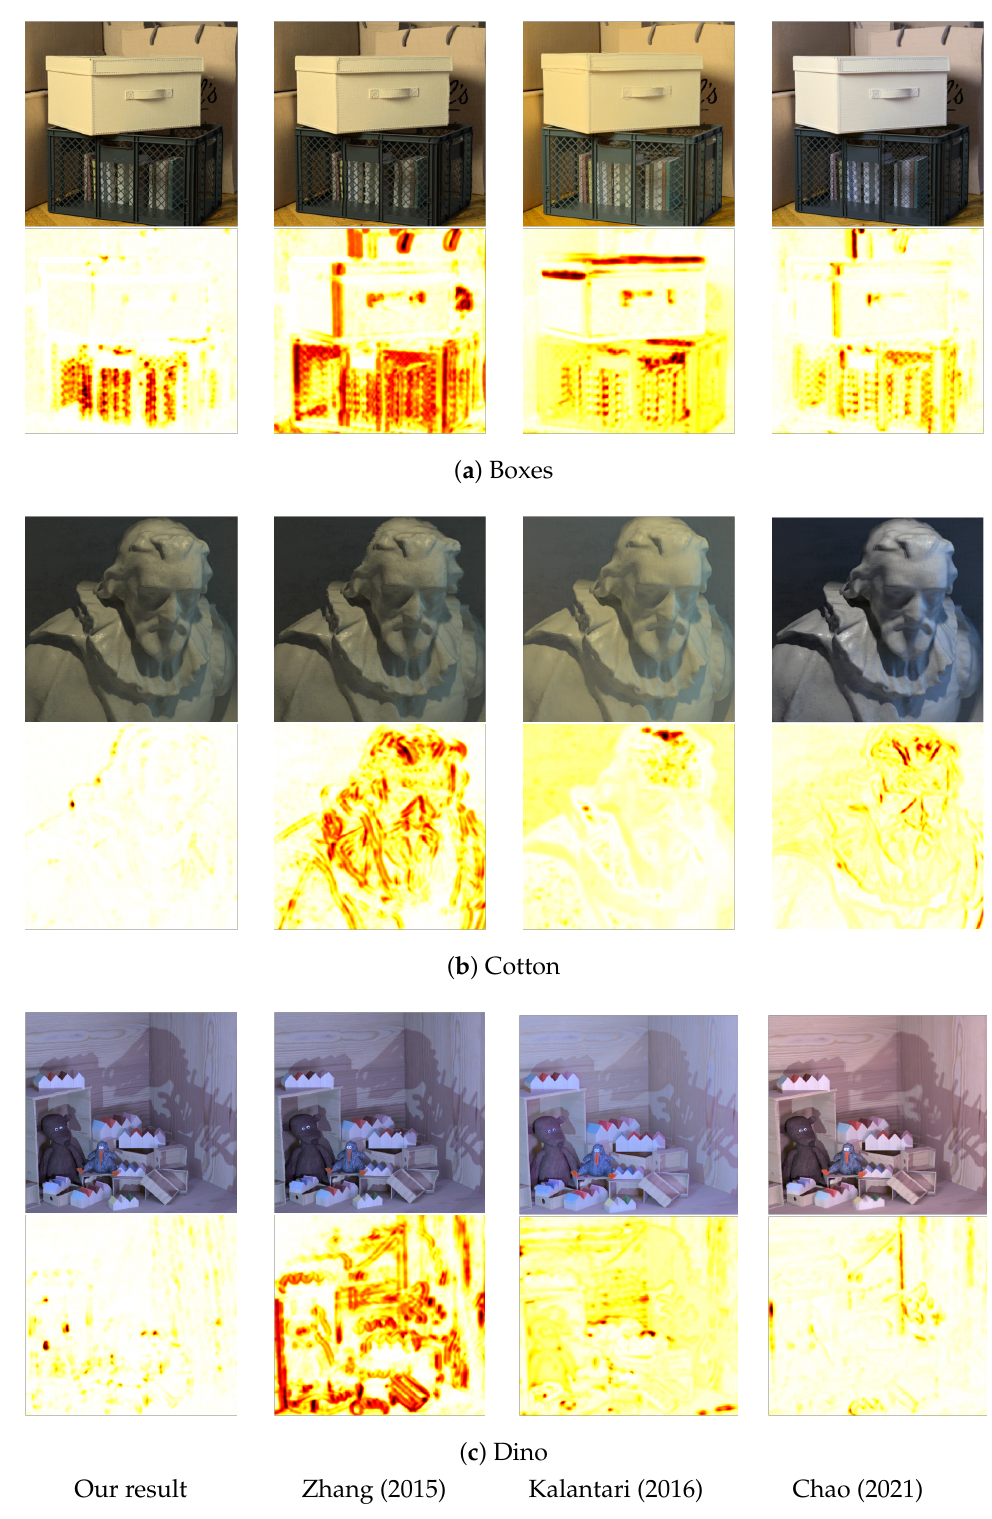
Figure 10. Visual comparison for the ’Boxes’, ’Cotton’, and ’Dino’ image synthesized leftmost horizontal sub-aperture view and the SSIM with the ground-truth sub-aperture view for the proposed algorithm, Zhang et al. [17], Kalantari et al. [21] and Chao et al.